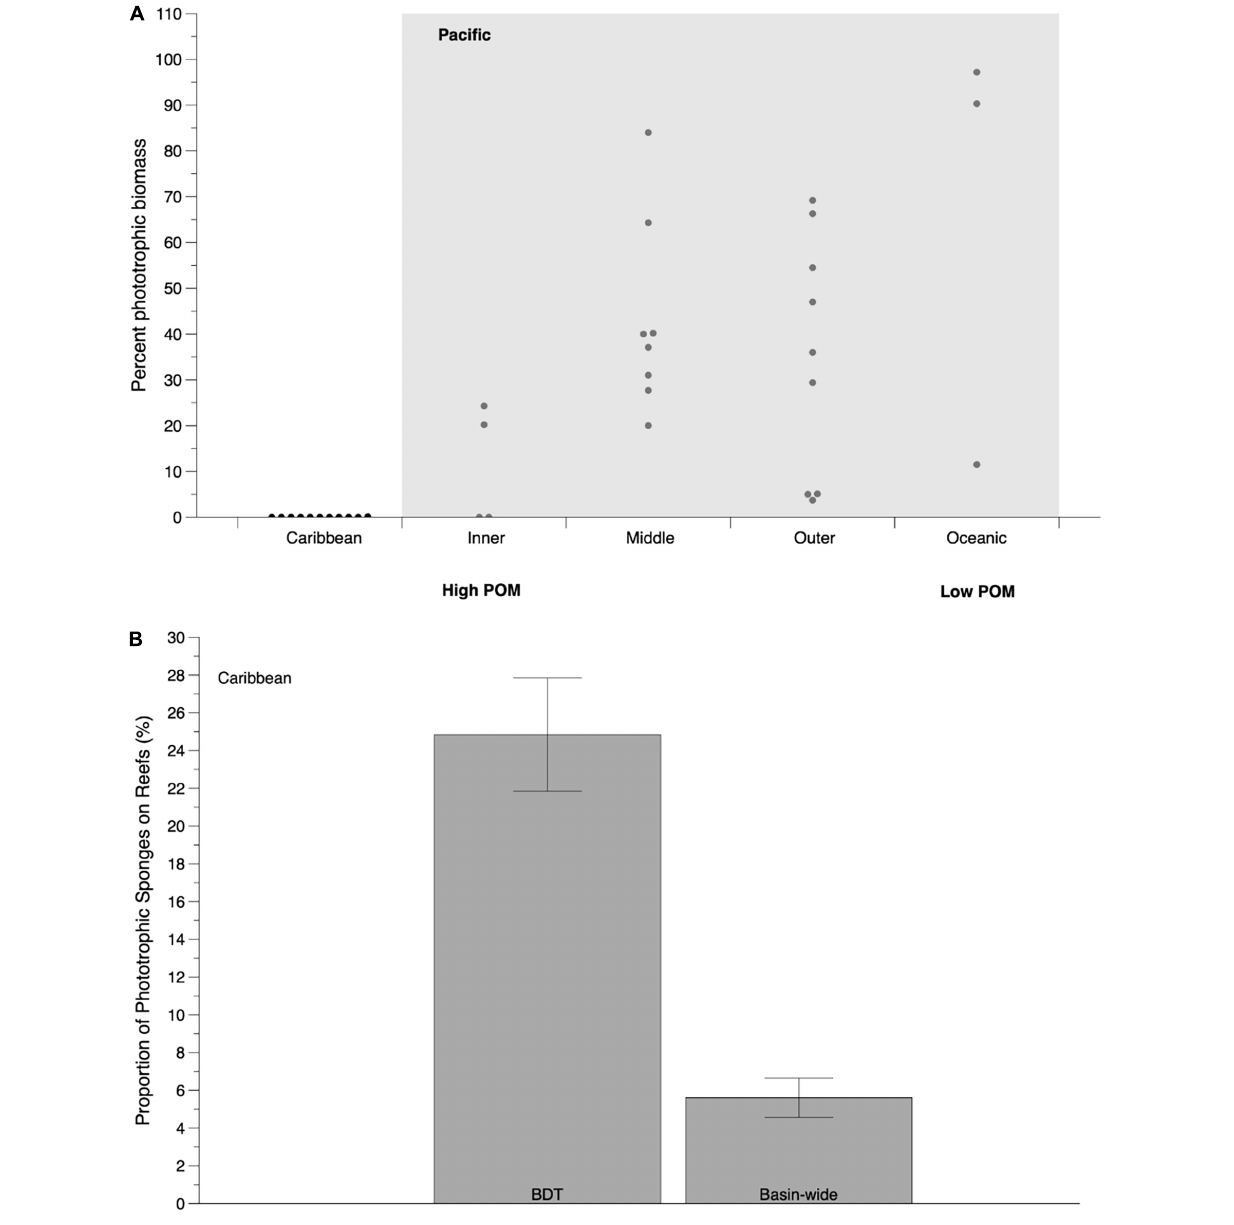
FIGURE 3 | (A) Abundance patterns of phototropic sponges across an inshore to offshore gradient in the Pacific (including Great Barrier Reef and Fiji; light gray box) and Caribbean using data from Wilkinson (1987) and Wilkinson and Cheshire (1990). Abundance is represented as the proportion of overall sponge biomass composed of phototrophic (P:R > 1.5) sponges and each point represents data from a single site within each reef category or ocean basin. Low and high particulate organic matter (POM) predictions are based on Wilkinson and Cheshire (1990). (B) Prevalence of phototrophic sponges (proportion of overall sponge cover from phototrophic species) in the Caribbean (both within Bocas del Toro, Panama [BDT] and Caribbean-wide) based on contemporary methods (Thacker et al., 2007; Erwin and Thacker, 2008; Freeman et al., 2013) and distribution data from Loh and Pawlik (2014) and Easson et al.